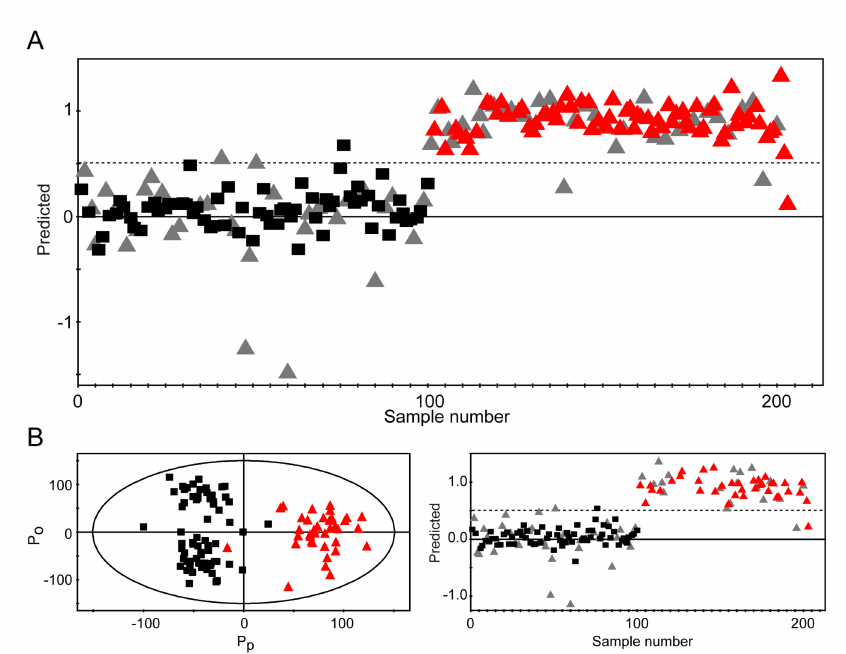
Figure 3. Prediction of healthy subjects and patients with gastric cancer using unknown samples and early-stage diagnosis. ( A ) For validation, 67 unknown samples (33 healthy control and 34 gastric cancer samples) were fitted into the OPLS-DA model. The class membership of the unknown samples was predicted using an a priori set cuto ff value of 0.5 (dashed line). The Y -values of the black boxes and red triangles are from the analysis of known samples (67 healthy control and 68 gastric cancer samples), and gray triangles represent unknown samples. ( B ) For early-stage diagnosis, the gastric cancer group only comprised patients with stage IA cancer ( n = 37), and the diagnostic model was established using the same healthy control group ( n = 67). Validation was performed with 52 unknown samples (gray triangles). Black boxes: samples from healthy controls; red triangles: samples from patients with gastric cancer. In the case of misclassified samples, the predicted Y -values for unknown samples are shown as gray